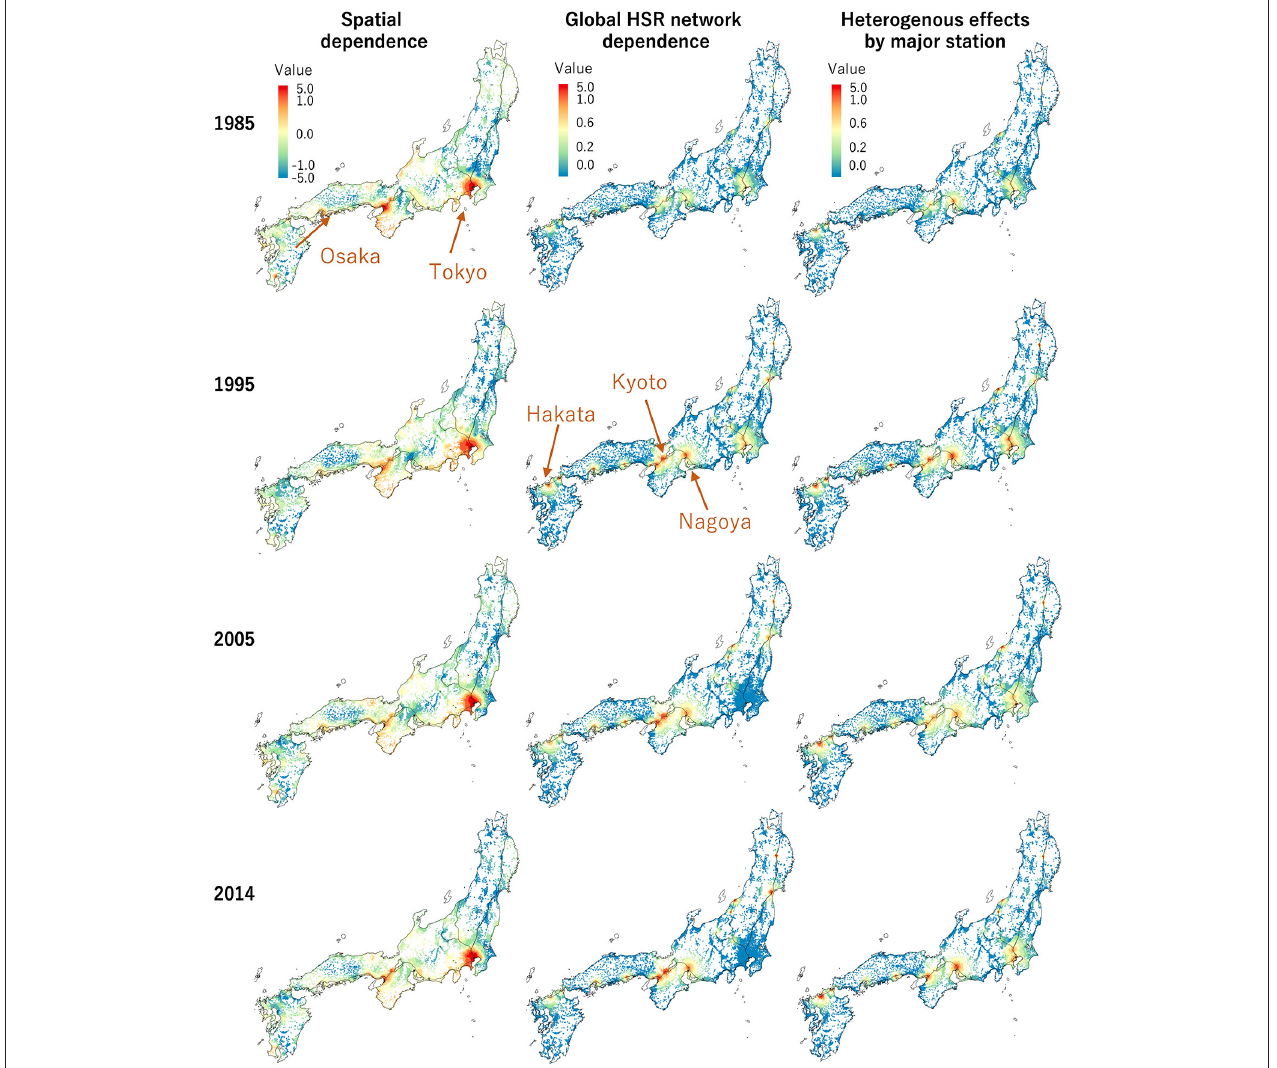
FIGURE 7 | Estimated spatial dependent effects and spill-over effects from the global network dependence through the HSR (1985, 1995, 2005, 2014). For comparison, the same color scale is assumed for all the panels in this figure and Figure 8 except for the left four panels in this figure.